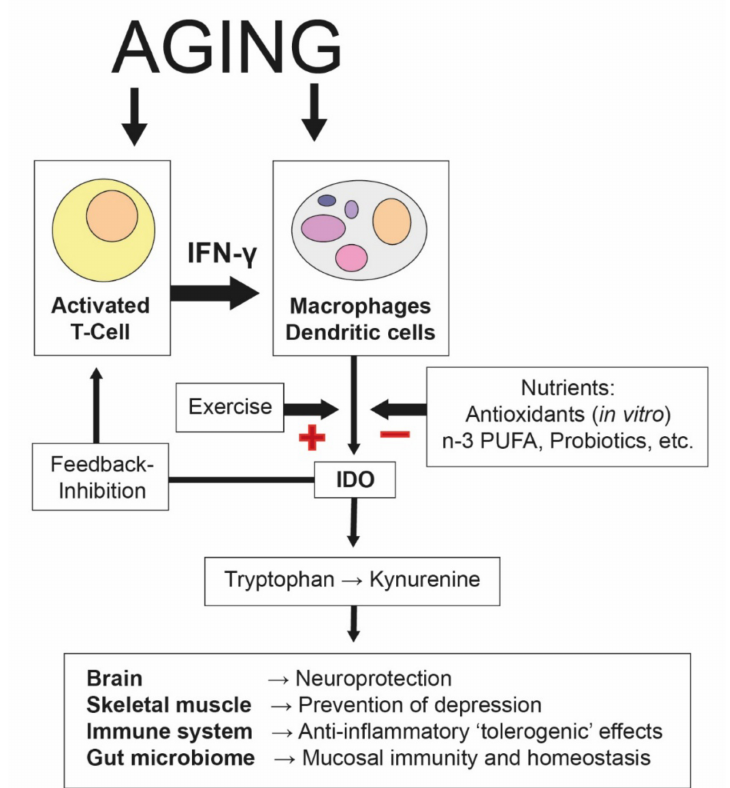
Figure 2. Aging-associated increases in indoleamine 2,3-dioxygenase (IDO). The process of aging involves proinflammatory pathways, in which the formation of Th1-type cytokine interferon- γ (IFN- γ ) is of the utmost relevance. IFN- γ stimulates several enzymes, including indoleamine 2,3-dioxygenase-1 (IDO), which degrades tryptophan into kynurenine, an integral defense mechanism in the cell-mediated immune response. In addition to its role in innate immunity, the kynurenine pathway also plays a role in the regulation of the immune response by slowing down T-cell proliferation. Some tryptophan catabolites have been shown to be involved in the feedback inhibition of T-cell activation via regulatory T-cells, and thus immunosuppression. A supply of certain nutrients and bioactive compounds (such as antioxidants, n -3 PUFAs, or probiotics) can suppress (“ − ”) IDO activity and slow down Th1-type immune activation cascades. On the other hand, physical exercise stimulates the (“ + ”) induction of IDO, which is associated with an accelerated tryptophan breakdown and an increased kynurenine / tryptophan ratio [76]. Kynurenine metabolites can a ff ect the brain and several other organs in peripheral tissues, where they induce local and systemic adaptations (see the main text for a description) [67]. Therefore, it is likely that kynurenine and its metabolites may contribute to the mediation of the health benefits of exercise and nutritional